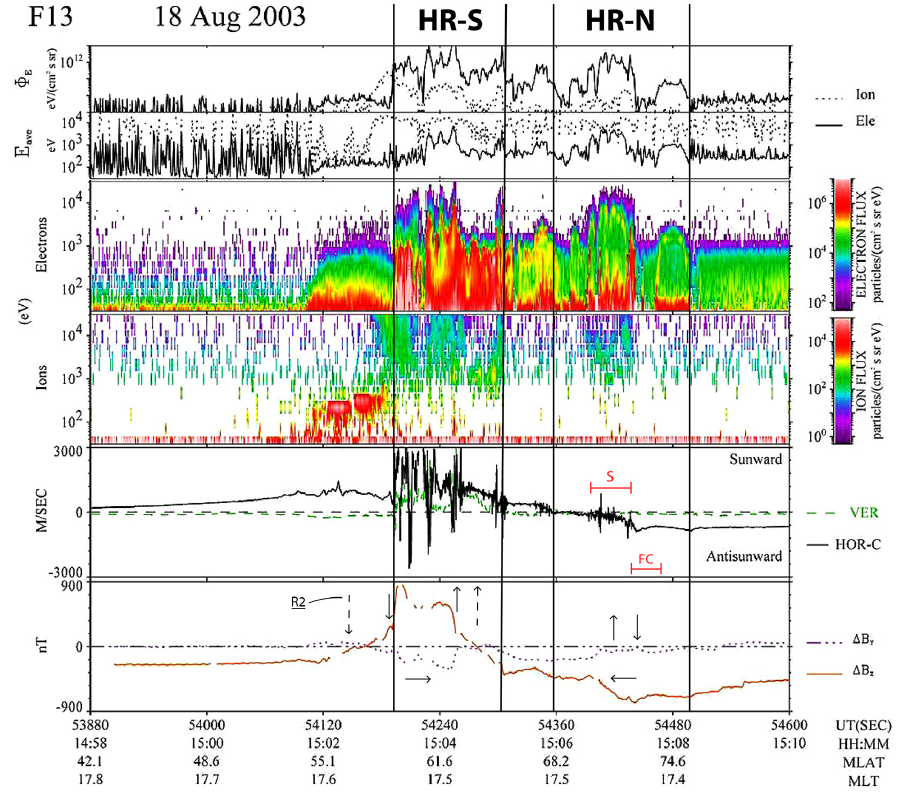
Fig. 6. DMSP F13 data for the traversal of dusk-side auroral oval (17.5MLT) from south to north during the interval 15:03–15:08:10UT. Same format as in Fig. 5. The latitude regimes Harang region-south and Harang region-north are marked by vertical guidelines. Major features of the FAC configuration are indicated by vertical arrows in the bottom panel. Auroral streamer (S) precipitation and associated flow channel (FC) in HR-N are marked in the ion drift